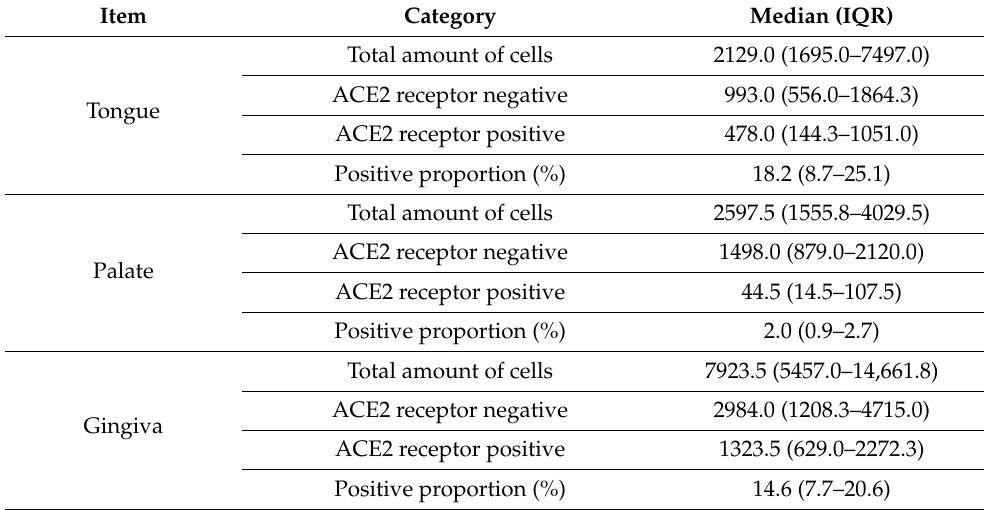
Table 2. Result of cytology (n =